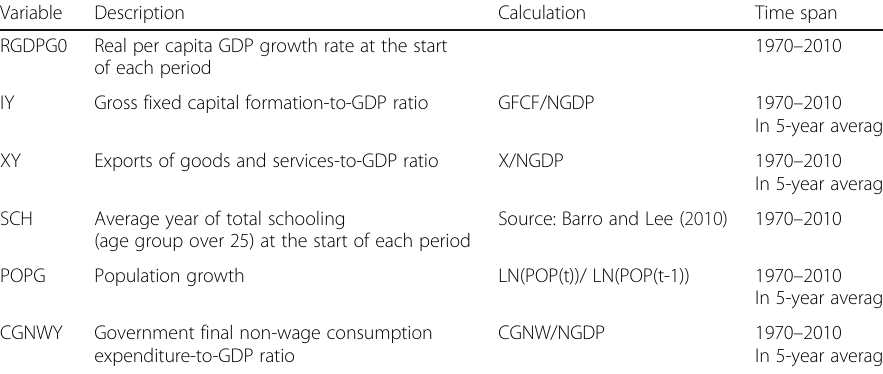
Table 25 Data used for the Barro type growth regressions Variable